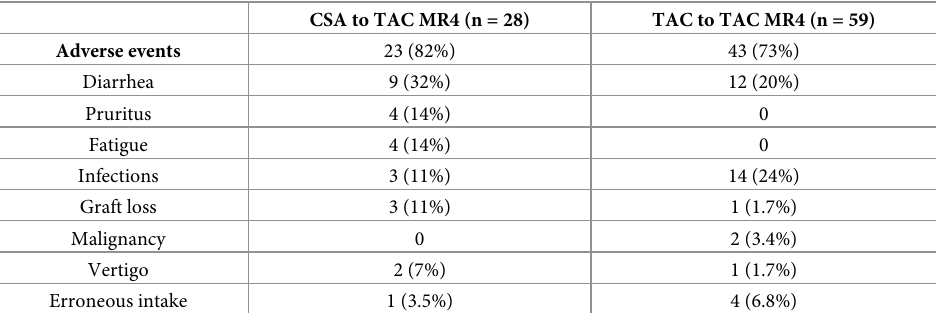
Table 3. Adverse events of 87 kidney transplant recipients after conversion from either ciclosporin (n = 28) or tacrolimus (n = 59) to modified release tacrolimus over 12 months.